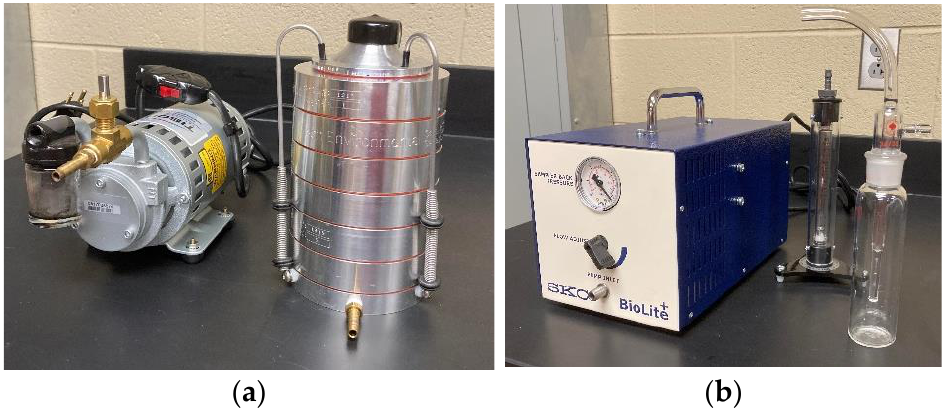
Figure 1. Two samplers: ( a ) Andersen six-stage impactor; ( b ) AGI-30 impinger.